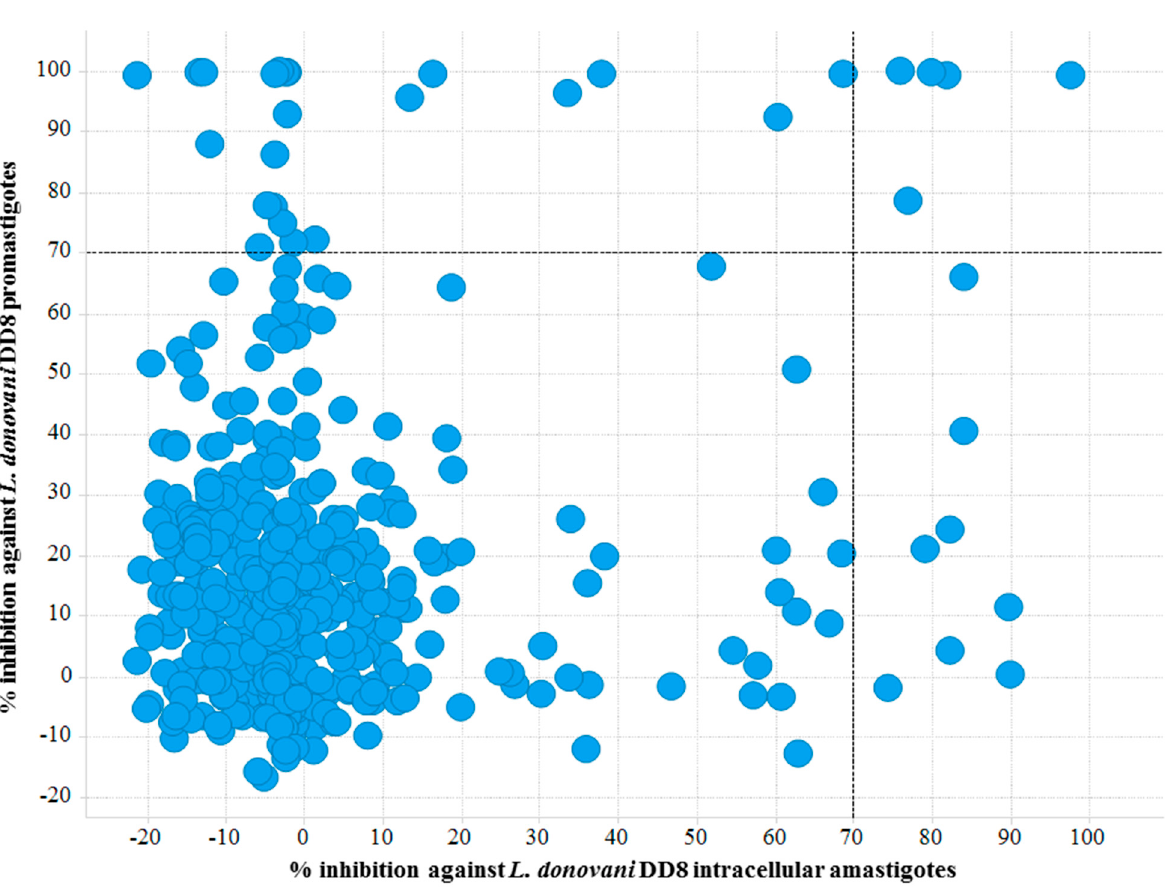
Figure 3. Scatter plot of active hits against L. donovani DD8 promastigotes and L. donovani DD8 intracellular amastigotes. Right top quadrant exhibiting compounds found to be active on both L. donovani DD8 promastigotes and L. donovani DD8 intracellular amastigotes.